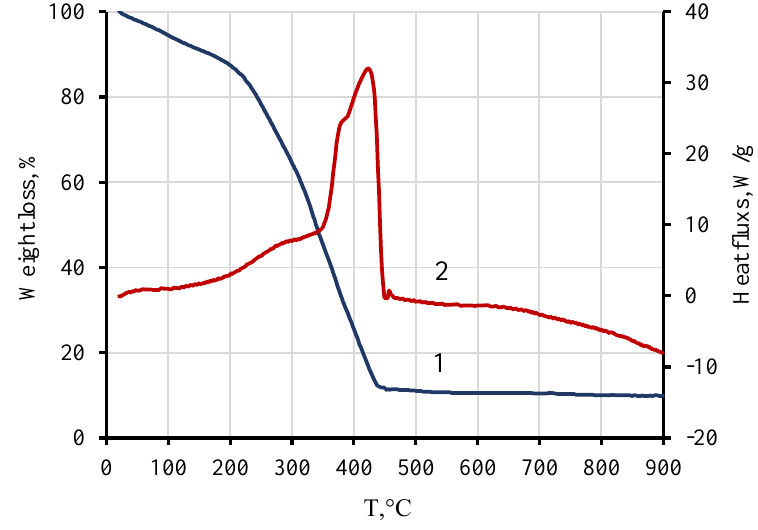
Figure 4. TGA (1) and DSC (2) curves of the xerogel obtained during the synthesis of PbFe 12 O 19 . The results for the composite ceramics 50 wt.% PZTNB-1 + 50 wt.% Pb 1− х La х Fe 12− x Zn x O 19 based